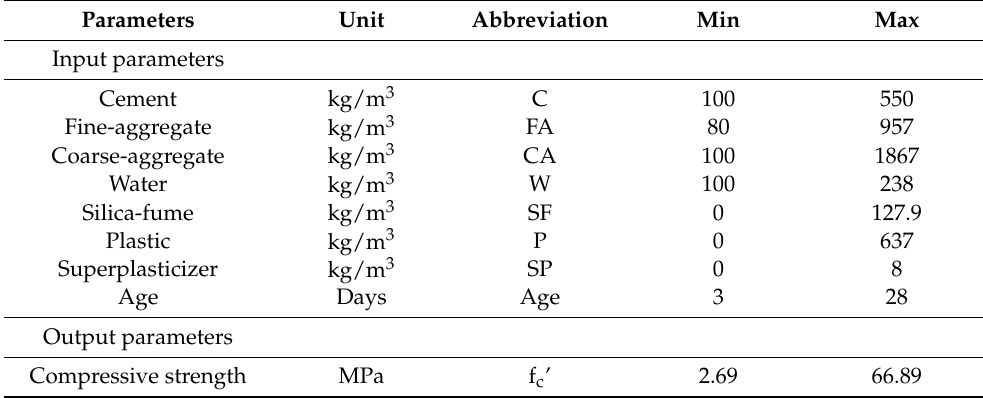
Table 3. The range of input and output variables for developing the compressive strength model of plastic concrete.